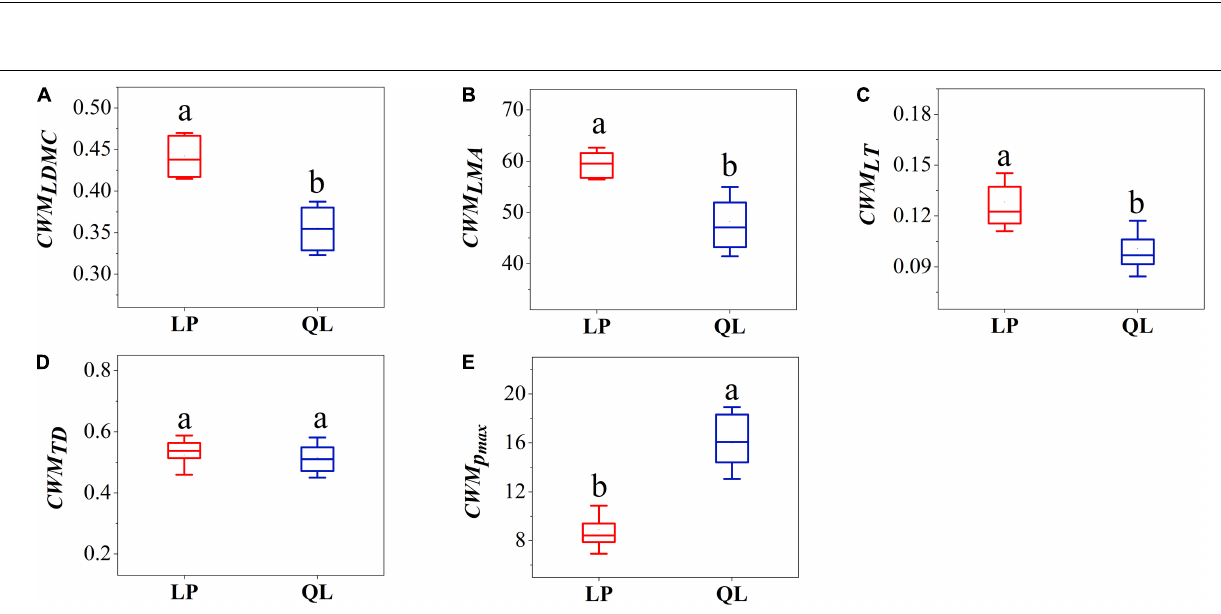
Frontiers in Plant Science |